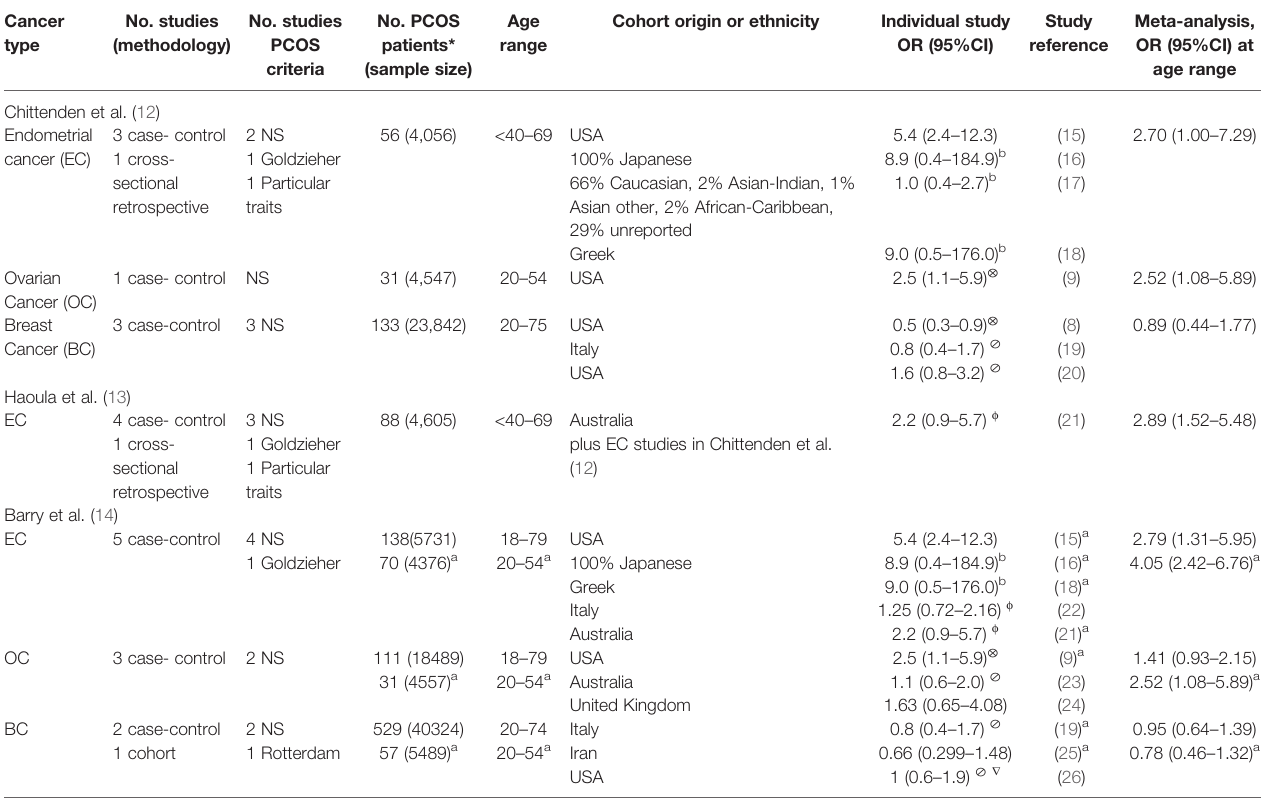
TABLE 1 | Meta-analysis that detect the risk of gynecological cancer and